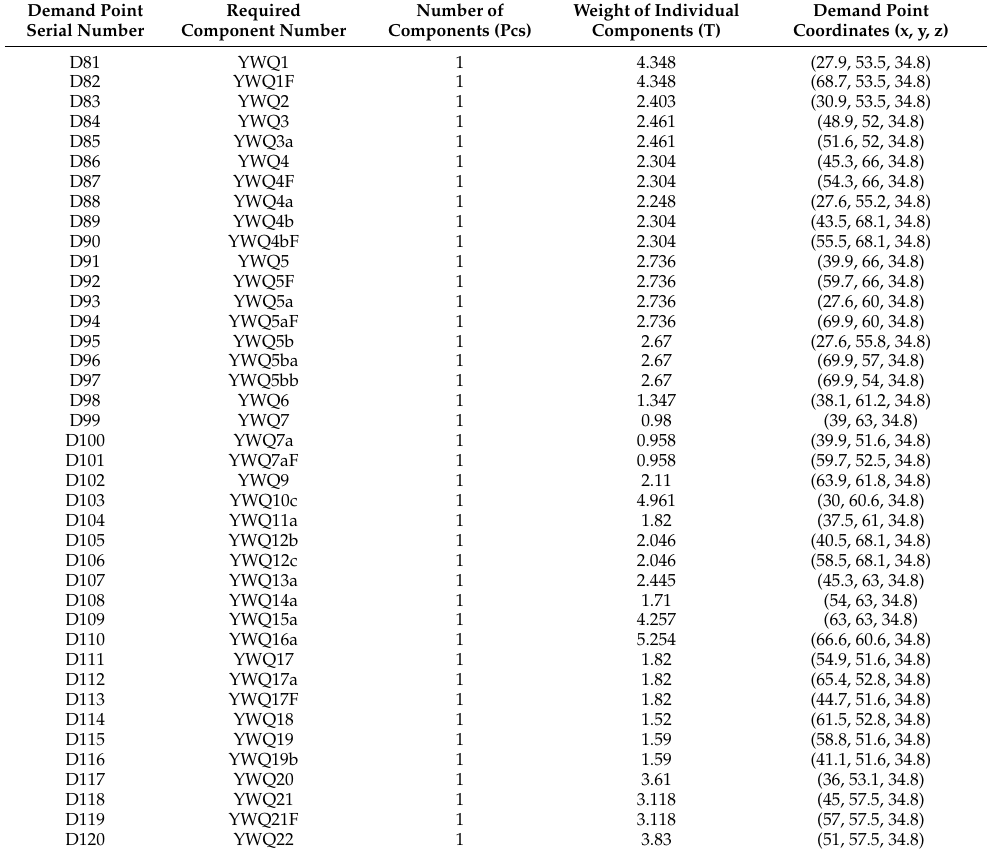
Figure 6. Plan of vertical prefabricated components of building #8. Building #8 is an assembly floor from the 5th floor onwards. The number of require- ments for each type of component and the weight of each component in building #8 are shown in Table 1. Table 1. Information table of prefabricated components demand for building #8 (13 floors, for ex- ample).